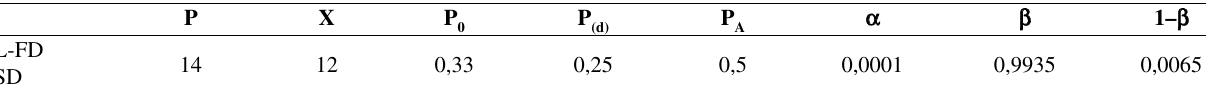
Table 13. – Sensory evaluation for strawberry fruit powders